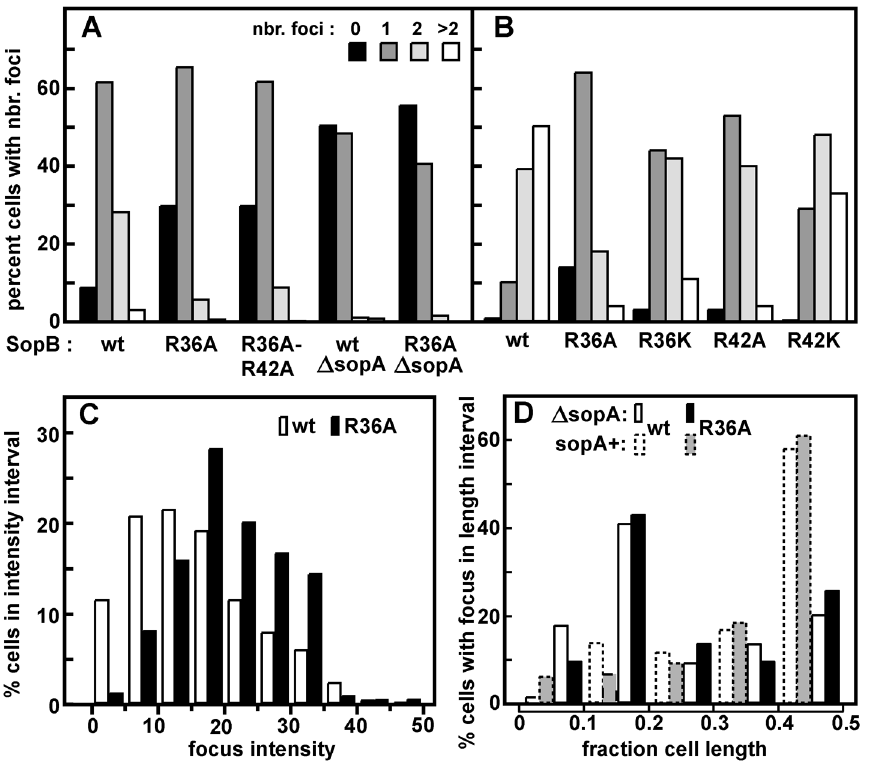
Figure 2. Effect of R36 and R42 mutations on mini-F clustering. Derivatives of strain DLT2583 ( para-tetR :: gfp ) carrying the tetO -array mini-F, pDAG848, and producing SopA and mutant SopBs in trans were grown in MGC medium (A) or LB broth (B), and the mini-F plasmid foci were visualized as described in Materials and Methods and counted. Total cells scored were: A - 756 (wt), 626 (R36A) 415 (R36A, R42A); 344 ( D sopA ); 368 ( D sopA , R36A); B - 2118 (wt), 3966 (R36A), 1874 (R36K), 1585 (R42A), 1736 (R42K). The wt and R36A focus number distributions in panel A were shown by the Student t-test to be different at a confidence interval of 95%. Sop protein concentrations relative to wt mini-F were measured by immuno-blot assay to be 1.9- and 2.2-fold (SopA) and 1.7 and 2.4-fold (SopB) higher in cells grown in MGC and LB respectively. C. Brightness of the foci in LB-grown cells, measured using Microbe Tracker. The distributions are different at the 95% confidence level by the Student t-test. Because focus intensity responds non-linearly to plasmid content (as seen elsewhere; e.g. [51]), foci in R36A cells were on average 1.3-fold brighter than in SopB-wt cells while consisting of 2.4 times as many molecules. D. Localization of pDAG848 without SopA. Cells were grown in MGC. The shortest pole-focus distances in single-focus cells were sorted into 1/10 cell-length classes. Dotted-line bars show distributions of single foci in the presence of SopA (Figure 5B). Distributions of focus brightness in D sopA cells containing wt and R36A SopB proteins were not significantly different at the 95% confidence level, by the same test as applied to the brightness data of Figure 2C (not